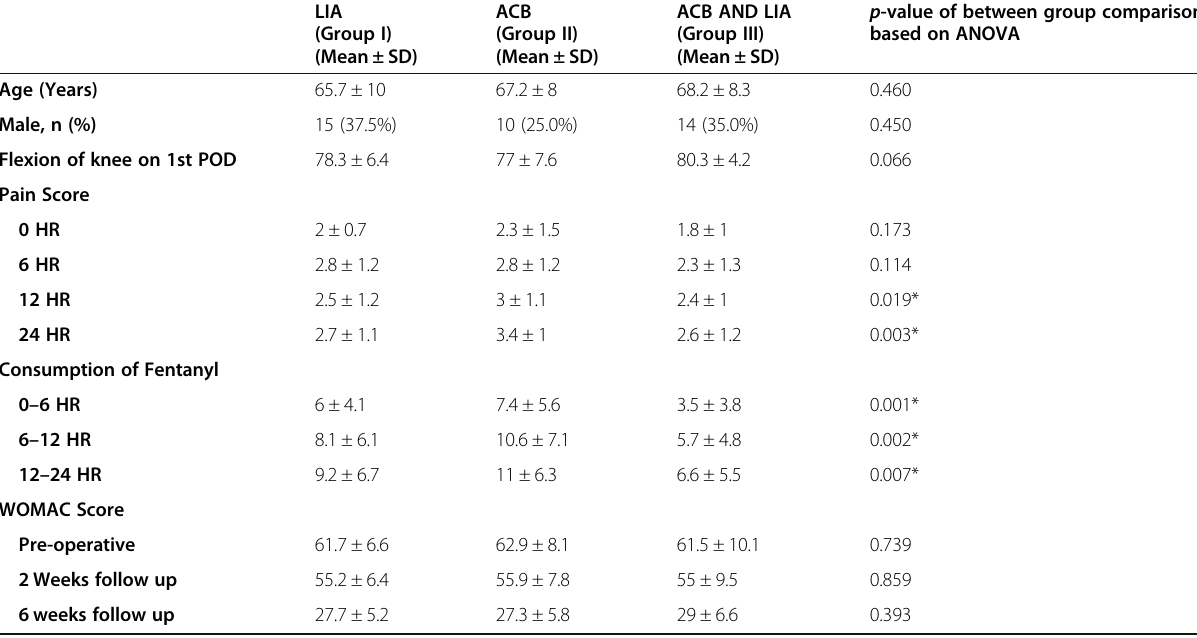
Table 2 Comparison of mean value of parameters between three groups (One Way ANOVA Test)